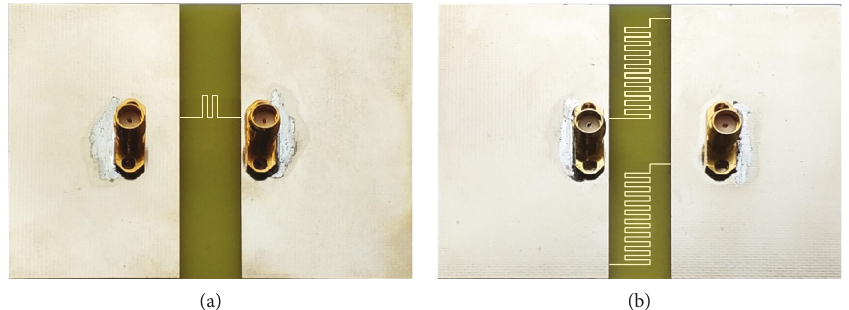
Figure 2: The photograph of the dual-element microstrip antenna array equipped with MLs. (a) The fi rst con fi guration. (b) The second con fi guration.